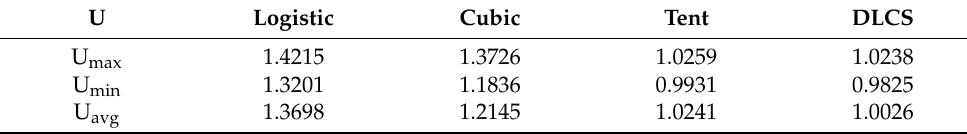
Table 2. Planar uniformity